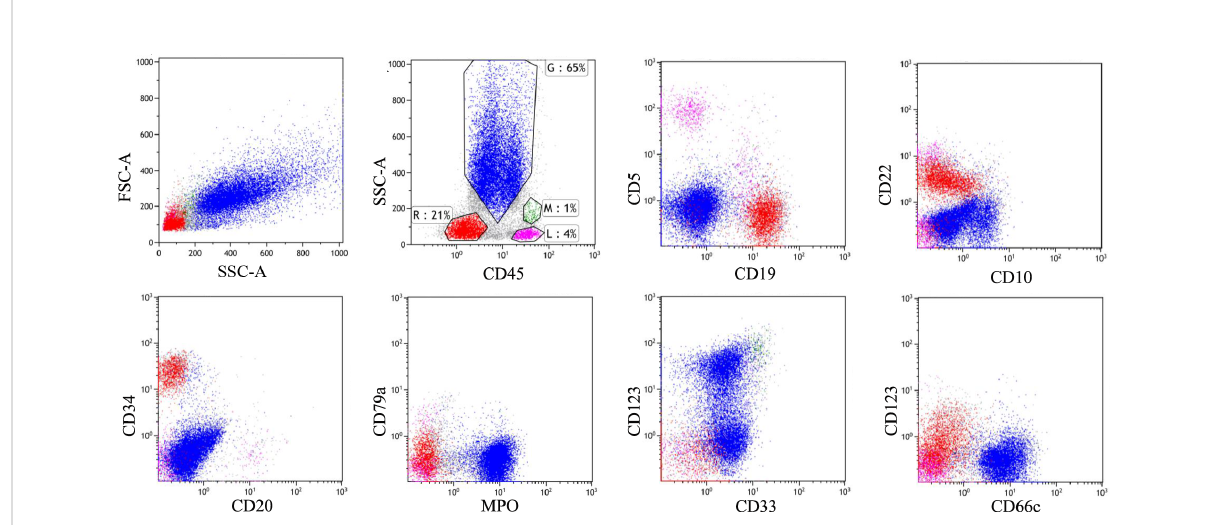
FIGURE 1 Immunophenotypic analysis by fl ow cytometry revealed a common B-cell acute lymphoblastic leukemia. There were 21% lymphoblasts expressing CD19+ in the bone marrow at the time of post-transplant recurrence, represented in